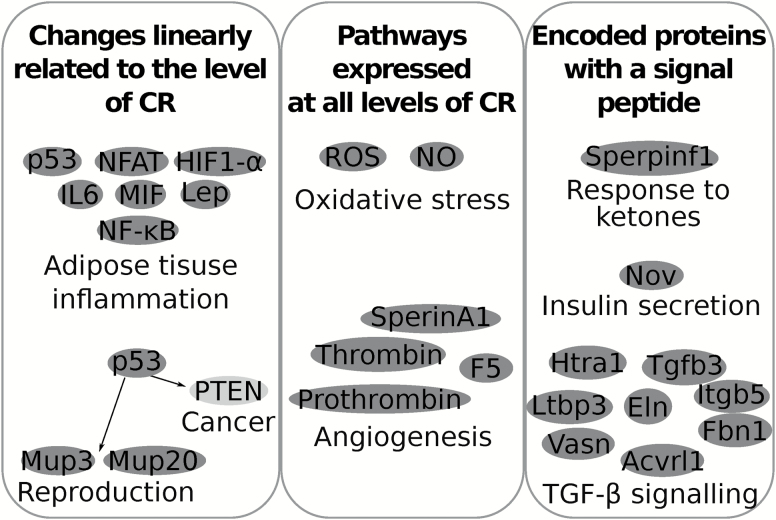
An integrated overview of the effects of graded calorie restriction on the adipose tissue transcriptome. The dark grey circles represent genes that were downregulated relative to 12AL and light grey represent an upregulation relative to 12AL. The genes are grouped according to their biological function. The three panels represent the results discussed in the three paragraphs included in the discussion.